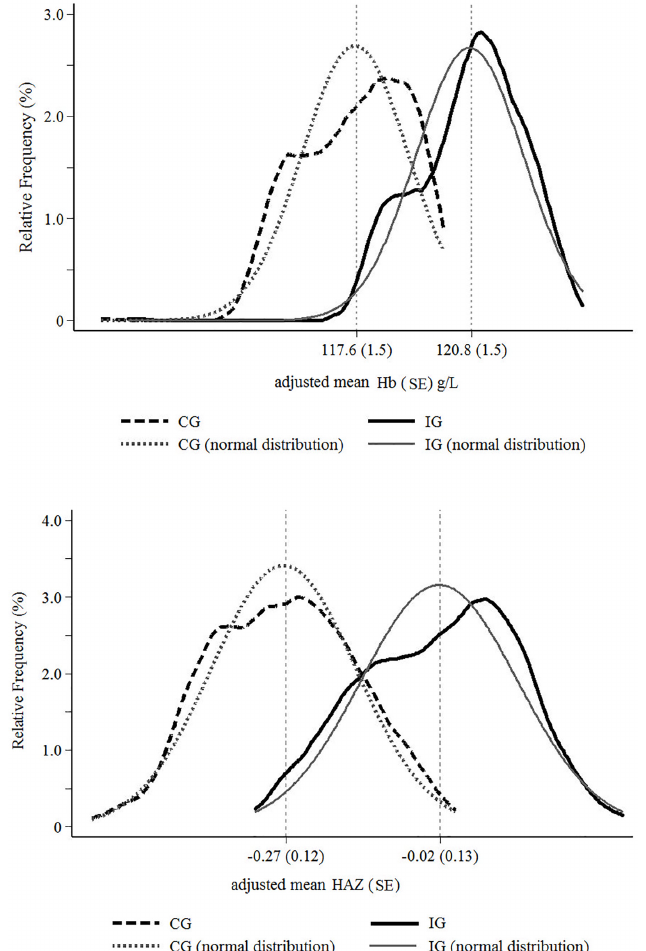
Fig 2. Relative frequency of hemoglobin (Hb in A ) and Z-scores for length-for-age (HAZ in B ) values adjusted for primary health center, city, child age and maternal schooling in multilevel linear regression analysis by ENFAC study groups. CG, control group; ENFAC, Estudo Nacional de Fortificaç ã o caseira da Alimentaç ã o Complementar ; HAZ, lenght/height-for-age Z-score; Hb, hemoglobina; IG, intervention